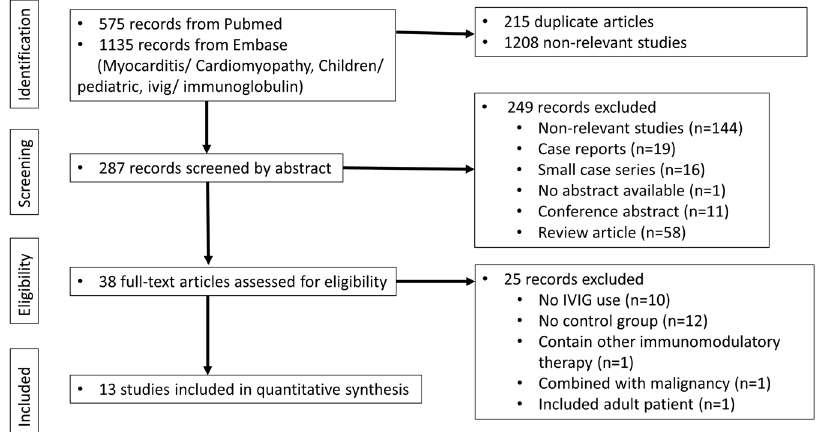
Figure 1. Selection of studies included in the